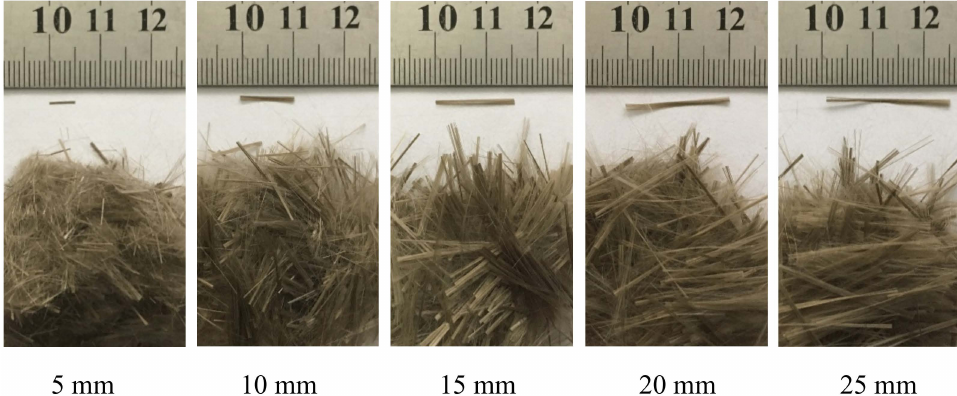
Figure 1. Photography of basalt fibres with different lengths. Table 2. Properties of basalt fibres.